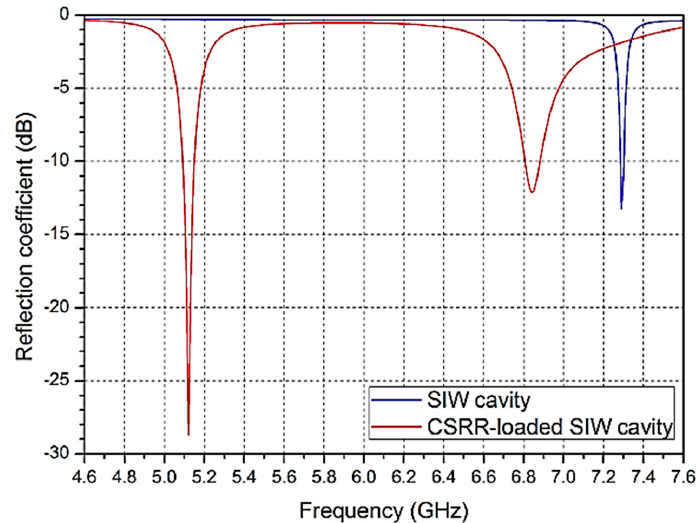
Figure 28. Simulated reflection coefficients of the SIW cavity (without a CSRR) and the CSRR-loaded SIW cavity (from [41]; copyright © 2014; reproduced with permission).